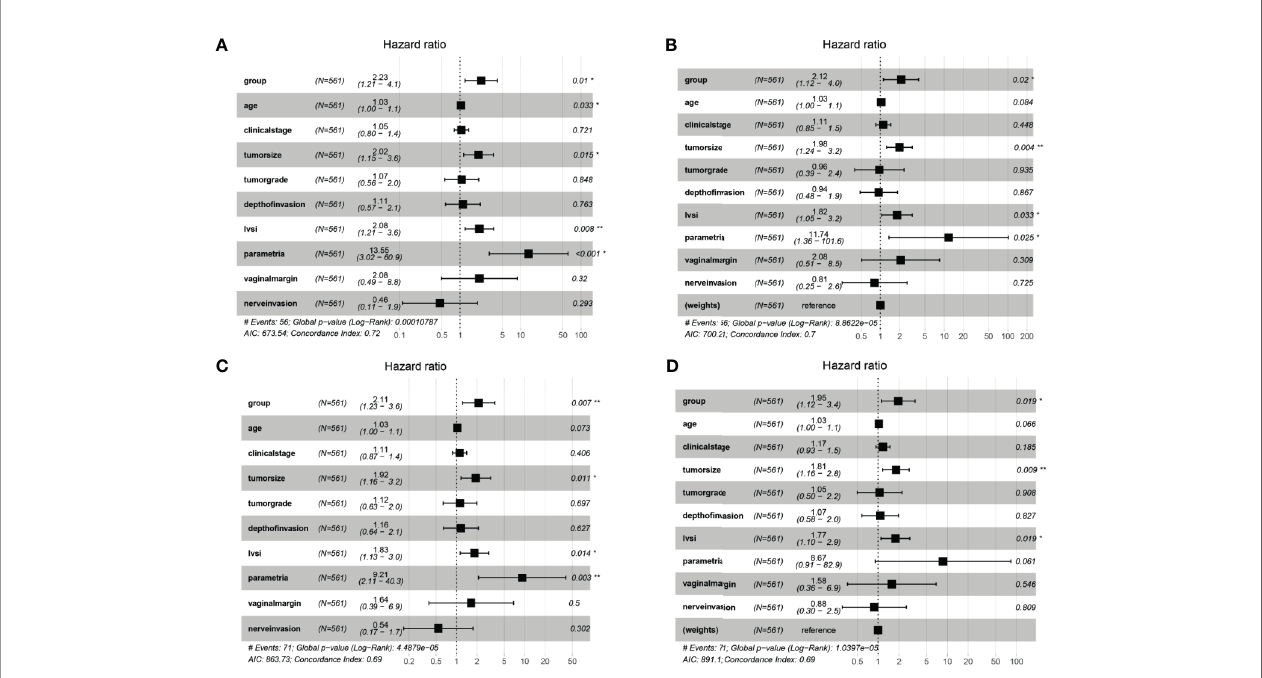
FIGURE 4 | Multivariate Cox proportional hazards regression analysis outcomes of the survival factors associated with overall survival (OS) and progression free survival (PFS) for patients in stage IA2-IIA2 cervical cancer based on Federation International of Gynecology and Obstetrics (FIGO) 2018 staging system. (A) Overall survival (OS) curves of the patients before propensity score-based inverse probability of treatment weighting (PS-IPTW) analysis. (B) OS curves of the patients after IPTW analysis. (C) Progression free survival (PFS) curves of the patients before IPTW analysis. (D) PFS curves of the patients after IPTW analysis. *P<0.05,